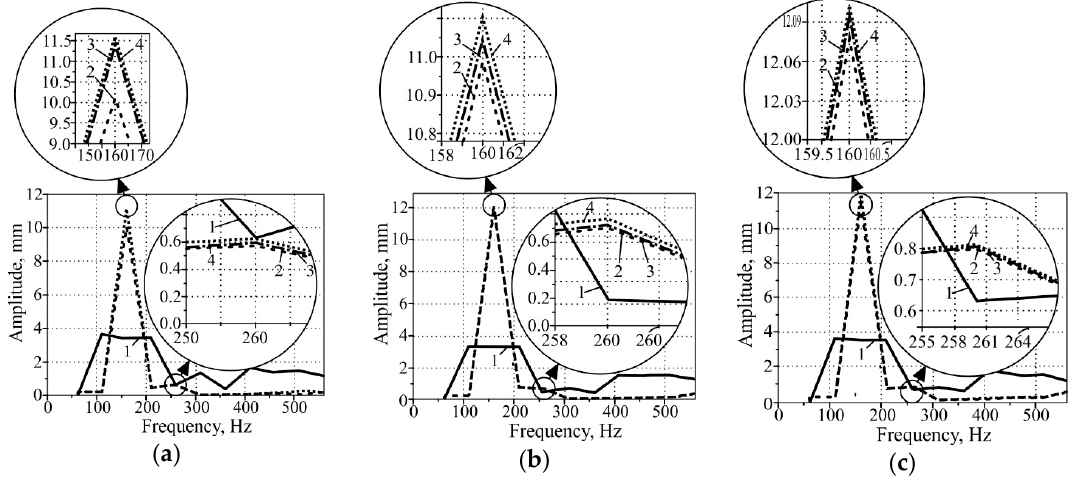
Figure 4. Amplitude–frequency characteristics of a 1350 mm length rope and broken wires: ( a ) actual diameter of the rope, 3.92 mm; ( b ) actual diameter of the rope, 3.96 mm; and ( c ) actual diameter of the rope, 4.0 mm (1, rope vibration amplitude; 2, 10 mm length broken wire; 3, 9 mm length broken wire; and 4, 8 mm length broken wire).